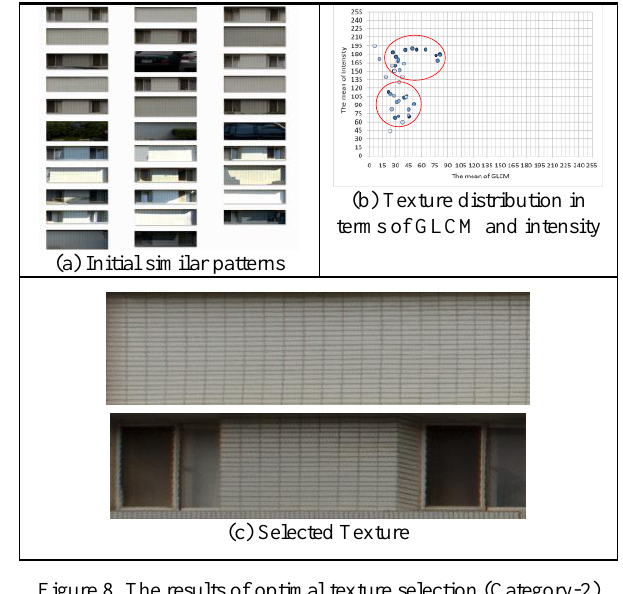
Figure 8. The results of optimal texture selection (Category-2)